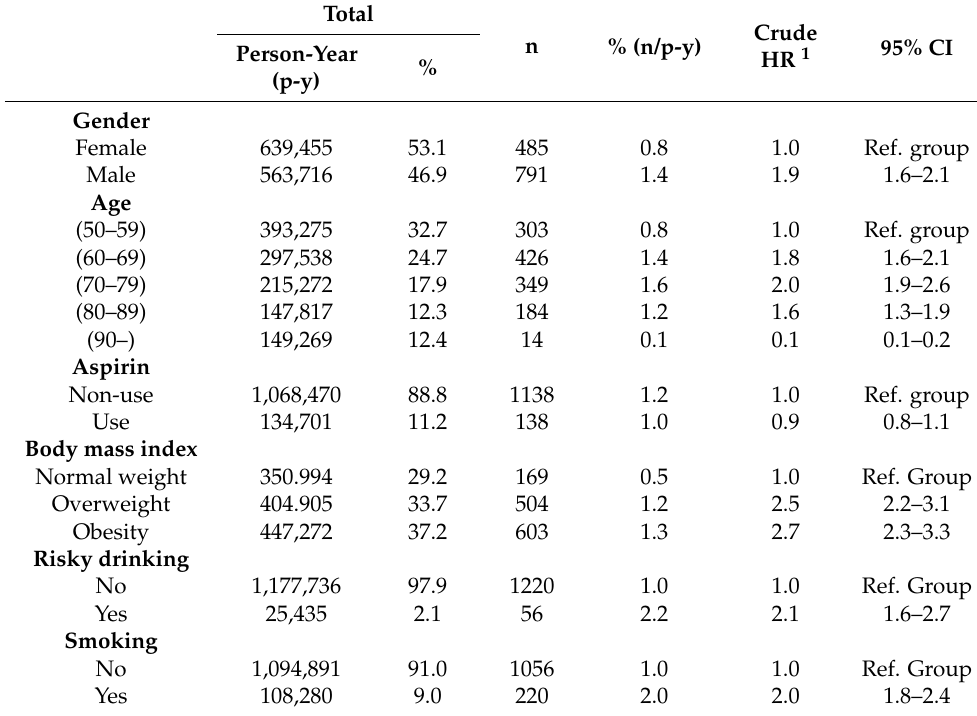
Table 2. Bivariate analysis with the observed years and CRC patients.